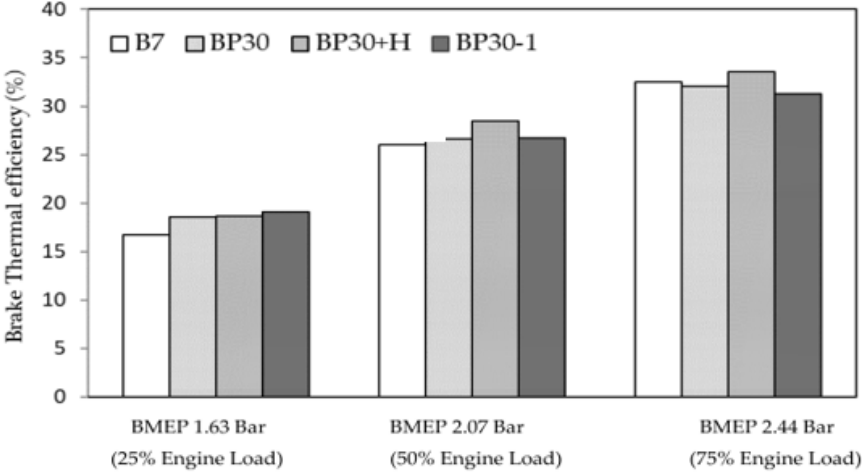
Figure 12. Effects of fuel enhancement on brake thermal efficiency.